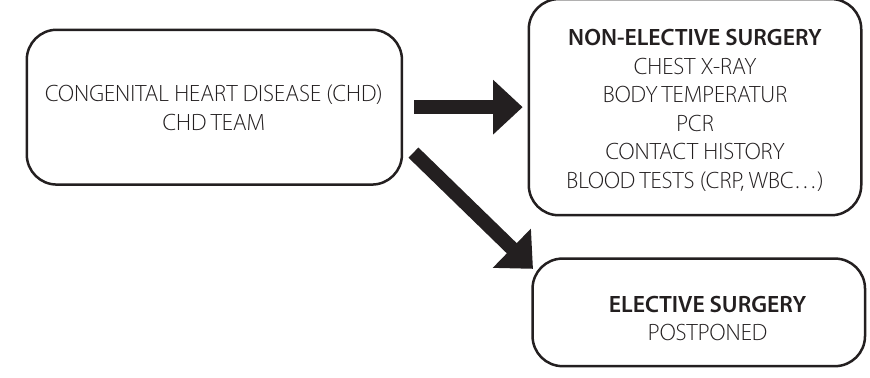
Fig. 1 - Algorithm for preoperative patients. CRP=C-reactive protein; PCR=polymerase chain reaction; WBC=white blood